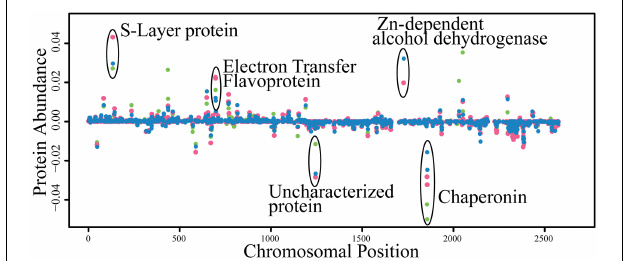
FIGURE 2 | Abundance of peptides detected from each condition mapped by genomic location. Proteins encoded by genes on the lagging strand are represented as negative abundance. Symbols: green circle, S. wolfei pure culture on crotonate; pink circles, S. wolfei-M. hungatei coculture on crotonate; blue circles, S. wolfei-M. hungatei coculture on